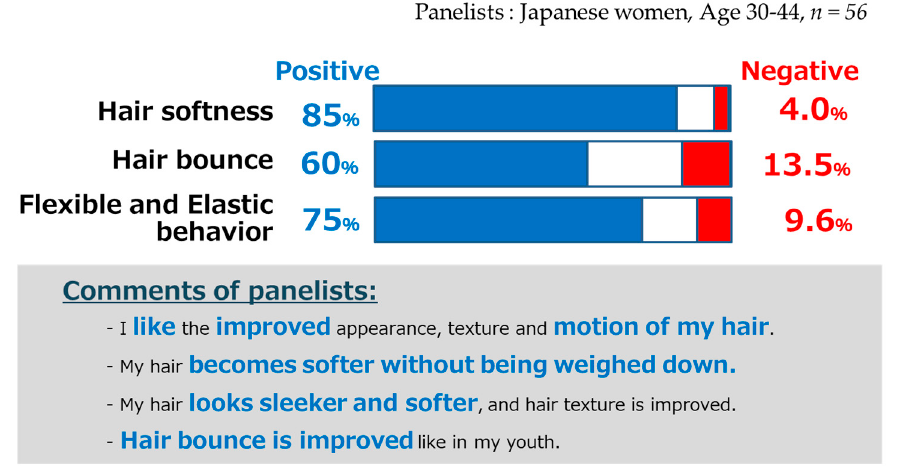
Figure 14. Effect of the three step system confirmed with Japanese consumers. Perceived changes in hair properties when the test formula is used.